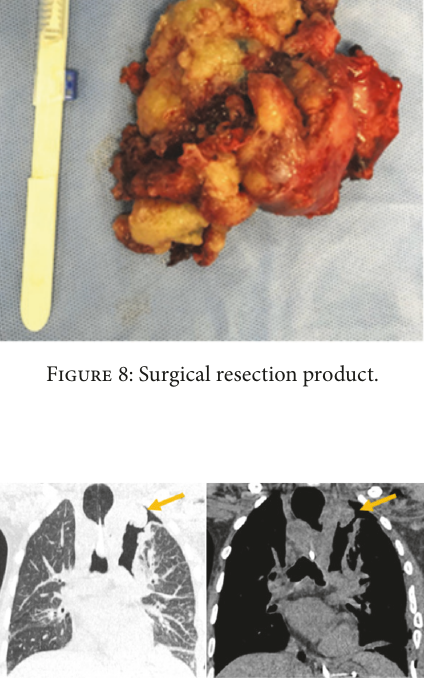
Figure 9: Chest tomography in coronal sections, in the lung and mediastinal windows, demonstrating the area of surgical manipula- tion and small residual lesion (yellow